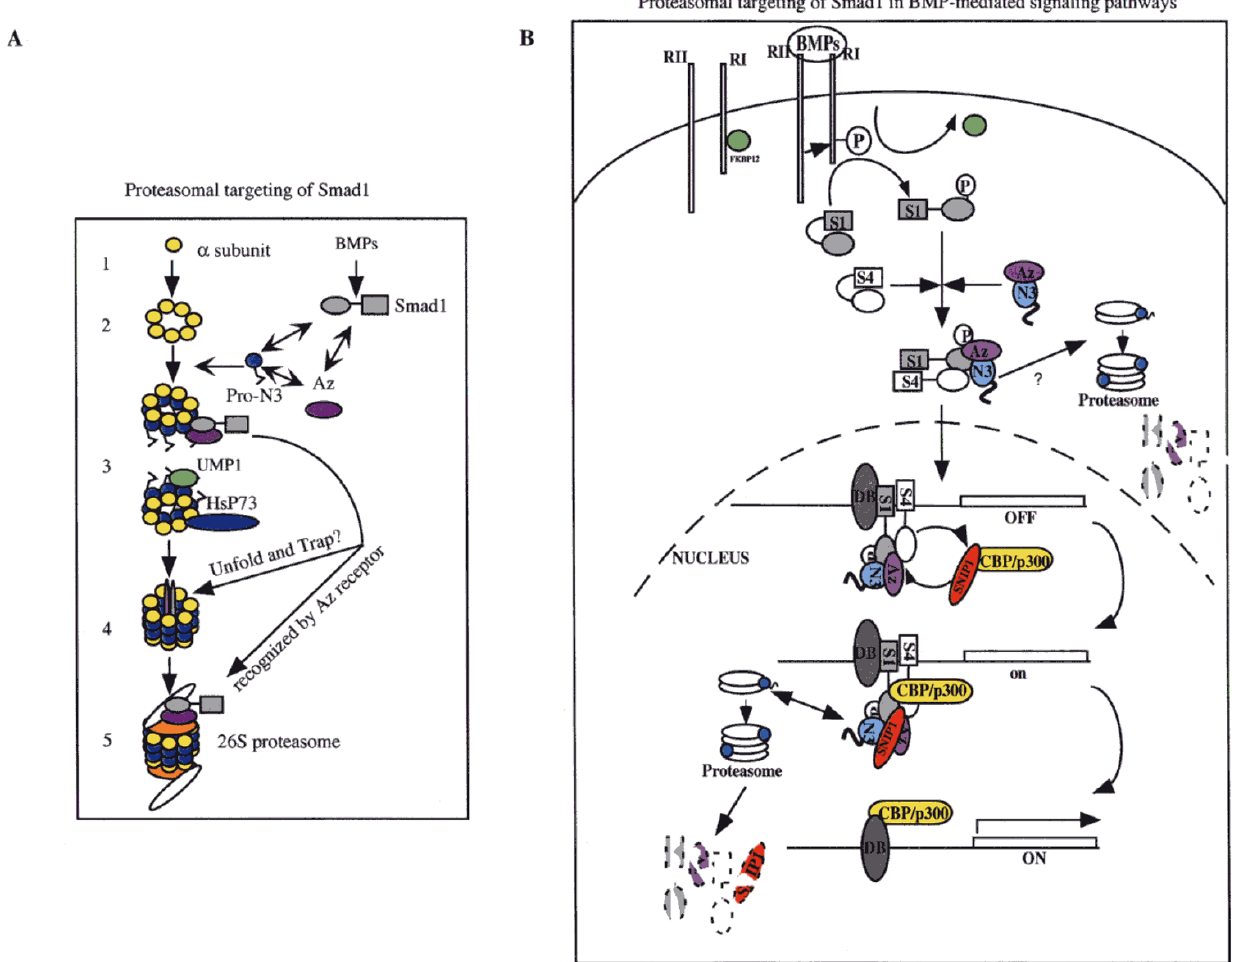
Figure 10 Mechanisms and functions of proteasomal targeting of Smad1 in signaling pathways of BMPs.A. A cartoon to illustrate a novel mechanism for BMP-induced proteasomal targeting of Smad1 induced by BMPs. The activation of BMP type I receptor enhances the interaction between Smad1 and two other proteins Az and HsN3. The newly synthesized HsN3 is in its prosequence-containing form, which forms a ternary complex with Smad1 and Az. The assembly of HsN3 brings Smad1 and Az to assembly intermediates (see step 3). The final maturation of the 20S proteasome may lead to the unfolding and trapping of Smad1 inside the degradation chamber and the ultimate proteasomal degradation of Smad1. Alternatively, Smad1/Az complex may be docked to a receptor of Az on 19S complex for the final delivery of Smad1 to proteasome for degradation. Two other proteins, UMP1 and Hsp73, which are known to be associated with proteasome assembly intermediates, are also shown. Upon the assembly of 20S proteasome, UMP1 is trapped inside of the 20S proteasome for degradation [46]. Hsp73 may play a role in unfolding proteins [35]. B. A cartoon to illustrate proteasomal targeting of Smad1 as an integral event along the signaling path- ways of BMPs. The activation of the BMP type I receptor is proceeded by type II receptor-mediated phosphorylation of the type I receptor and by the dissociation of the cytoplasmic inhibitor FKBP12 from the type I receptor. The activated type I receptor induces Smad1 phosphorylation and the subsequent formation of a complex of Smad1, Smad4, Az and HsN3, which is in its pre-assembled form containing the prosequence. The complex is then translocated into the nucleus, where Smad1 and Smad4 are recruited to specific DNA-binding sites near those of other DNA-binding transcription factors (DBs). In cells where most of the CBP/p300 is bound to SNIP1, the removal of SNIP1 from CBP/p300 may be a critical step for the successful recruitment of CBP/p300 to DBs. One way to remove SNIP1 could be via the recruitment of SNIP1 to Az and HsN3 in the complex containing Smad1 and Smad4. The targeting of Smad1 to proteasome, as illustrated in panel A, could then mediate the co-targeting of SNIP1 to proteasome for degradation. The removal of SNIP1 then allows the subsequent recruitment of CBP/ p300 to DBs for transcription. Possible cytoplasmic targeting of Smad1-containing complex via HsN3 assembly pathway is also suggested. See text for